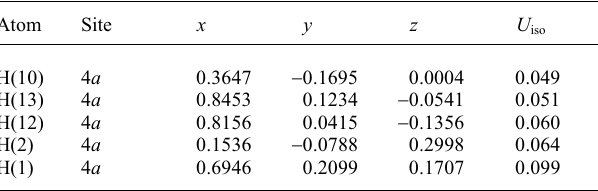
Table 2. Atomic coordinates and displacement parameters (in Å 2 )